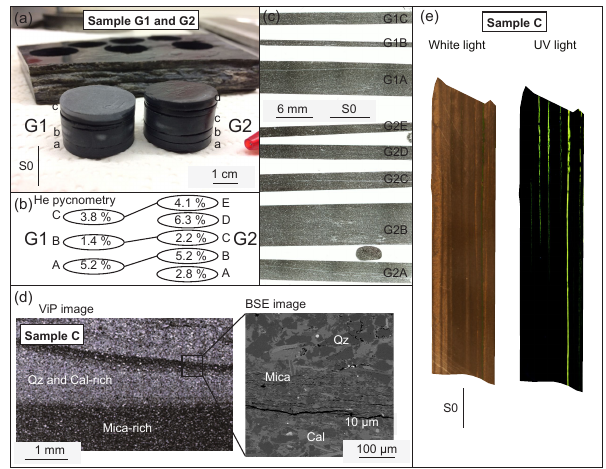
Figure 3. Sample preparation and heterogeneity. (a) Sample plugs (G1 and G2) are drilled bedding-perpendicular and directly next to each other. The plugs fall apart in sub-samples along the bedding planes. (b) Results of He-pycnometry measurements on individual sub-samples from A indicate limited horizontal but substantial ver- tical variations in porosity. (c) Photograph of thin section obtained from the sub-sample plugs indicated in A show that the bulk sam- ple is relatively homogeneous. (d) Selecting areas of interest from ViP images for further SEM investigation. (e) Polished sample C in white and UV light; note fractures on macroscale. Qz: quartz; Cal: calcite; S0: bedding; and BSE represents backscatter